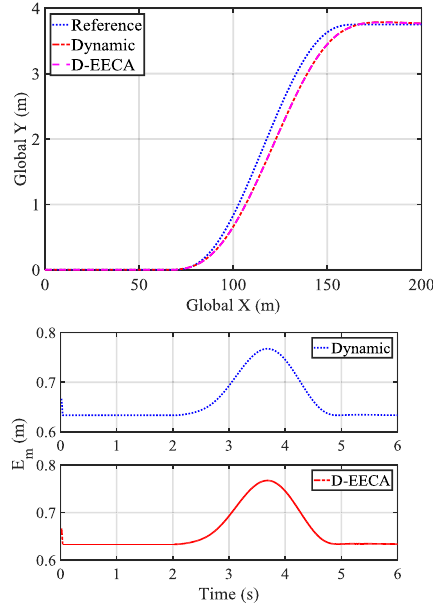
Figure 8 The position of A-IWMs EV and tracking